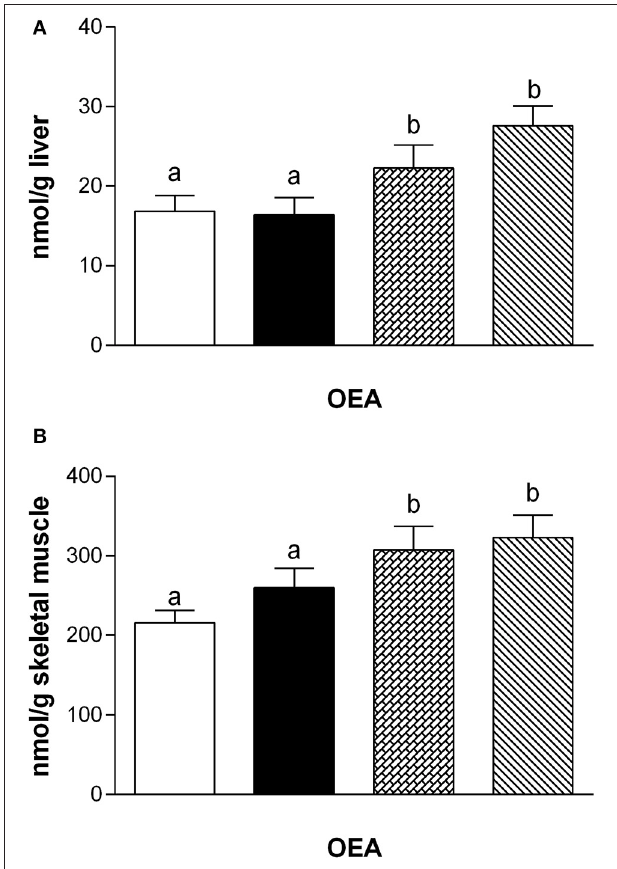
FIGURE 3 | Tissue levels of oleylethanolamide (OEA). The graphs show the liver (A) and skeletal muscle (B) levels of OEA. Data are presented as means ± SEM from n = 7 animals/group. Labeled means without a common letter differ ( P < 0.05).